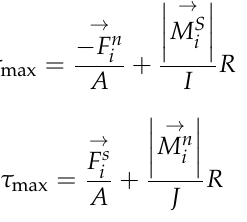
In the parallel bonding model, tangential force between particles;